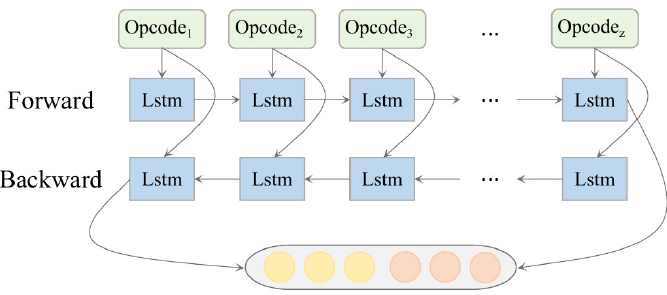
Figure 4. Bi-LSTM data processing process.